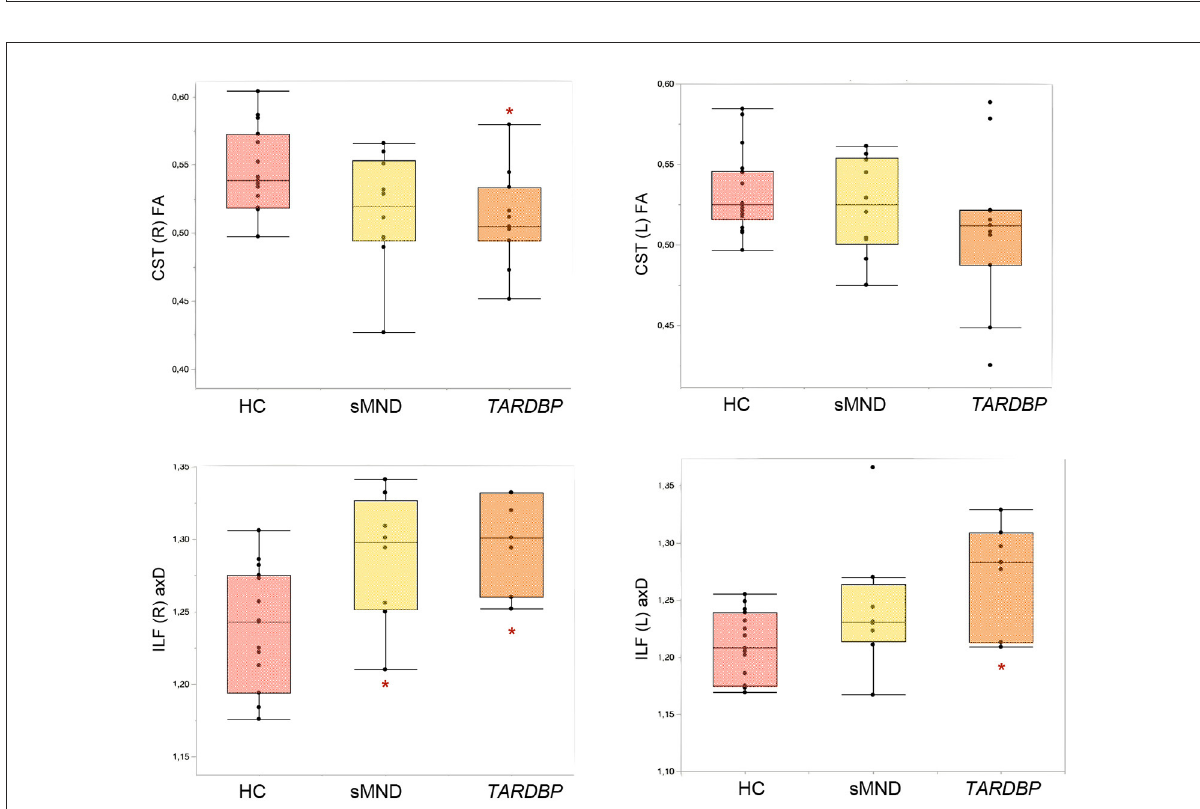
FIGURE3 Diffusion tensor (DT) MRI metrics of white matter (WM) tracts showing significant differences in MND patients and controls. Comparisons between groups were performed using age-, sex-, and MRI scanner-adjusted analysis of variance models, followed by post hoc pairwise comparisons, Bonferroni-corrected for multiple comparisons. CST, corticospinal tract; HC, healthy controls; ILF, inferior longitudinal fasciculus; L, left; R, right; sMND, sporadic motor neuron disease. * Significantly different from HC.